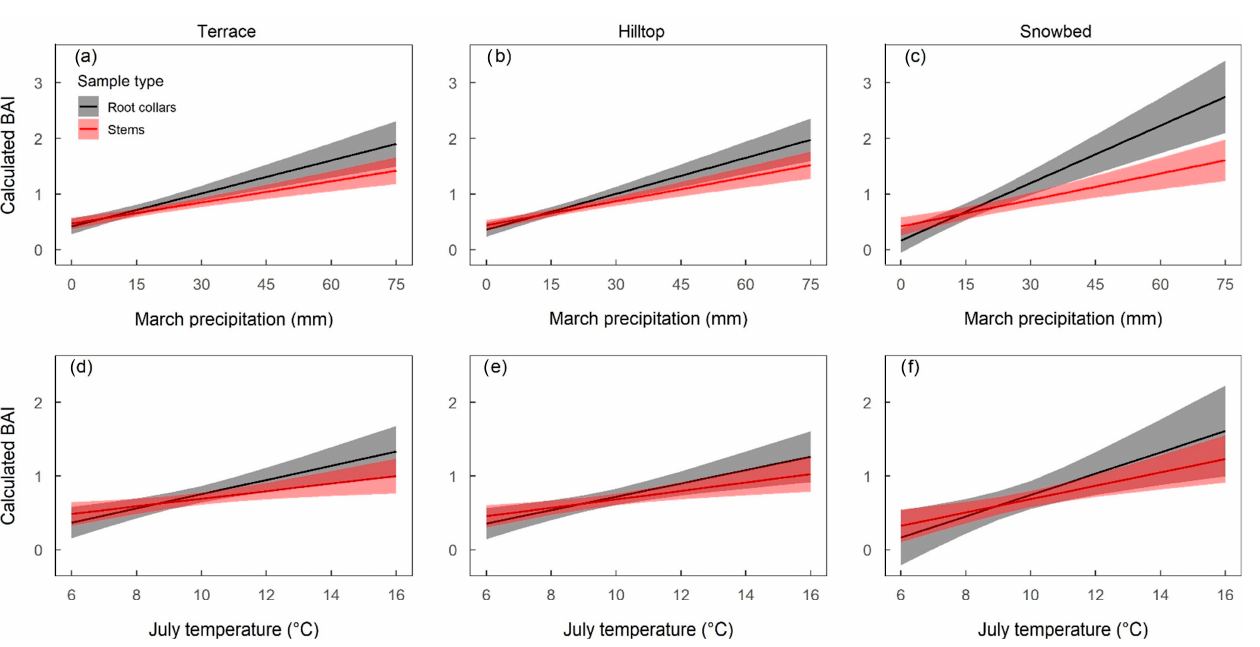
Figure 5. Predicted calculated BAI values for root collars (black) and stems (red) of Betula glandulosa according to the best climatic models: March precipitation ( a – c ) and July temperatures ( d – f ) for the 1947–2009 period. Shaded areas represent 95% confidence intervals.